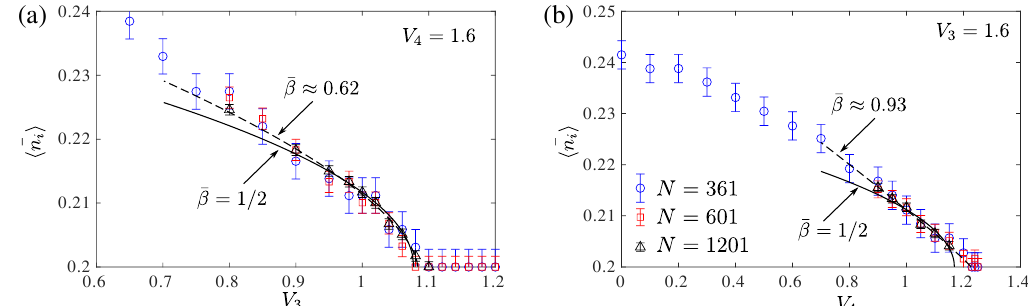
Figure 11: Scaling of the average density ¯ n inside the floating phase upon approach- ing the period-5 phase (a) along the horizontal cut at V = 1.6. Solid (dashed) lines are results of the fit ∝ | V vertical cut at V 3 with fixed (fitted) value of the critical exponent ¯ β